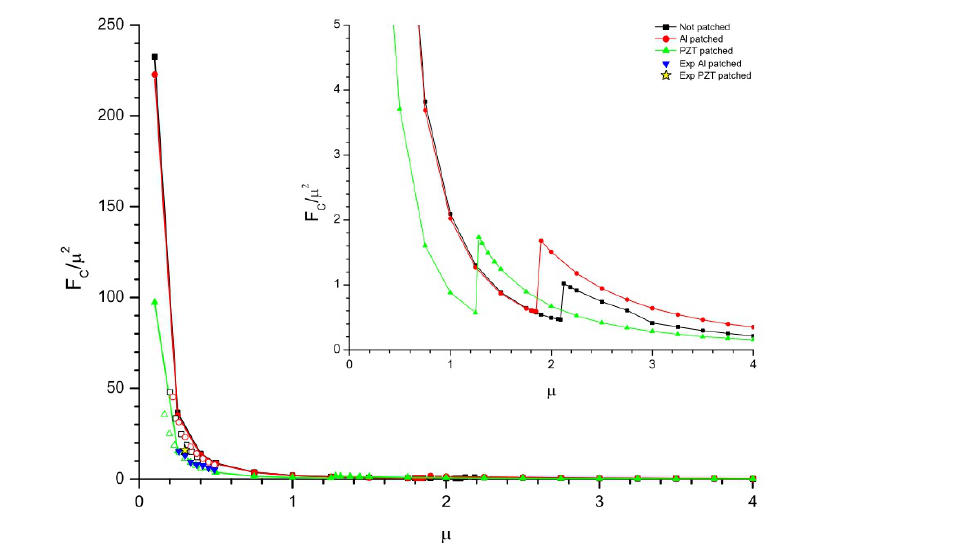
Figure 13. Flutter for reduced critical frequency; where µ = ρ F L / ρ S t and F C / µ 2 = (cid:104) (cid:16) (cid:17)(cid:105) ( ρ ) 3/2 / f c ρ F D 1/2 P h